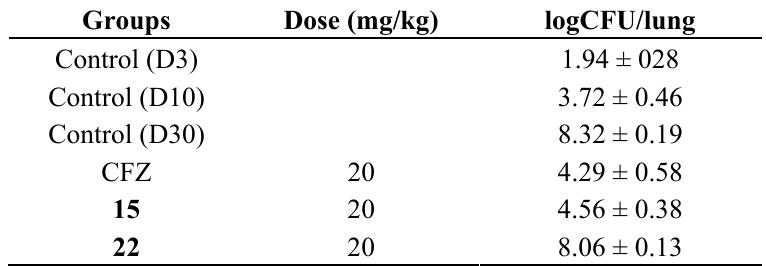
Table 3. Efficacy of CFZ, compounds 15 and 22 after 30 days of treatment of BALB/c mice infected with M. tuberculosis H37Rv. (mean ± SD) a